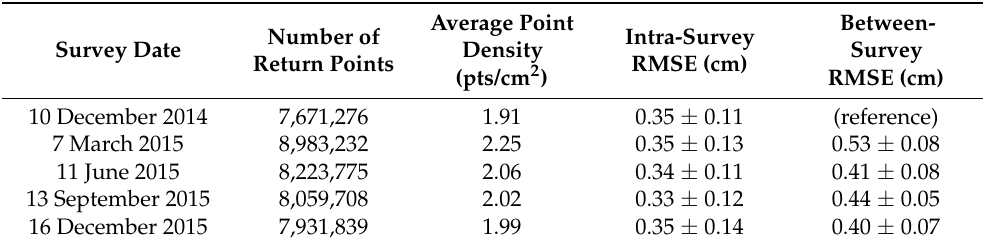
Table 1. TLS-collected point cloud data of an engineered hillslope in Loudon County,